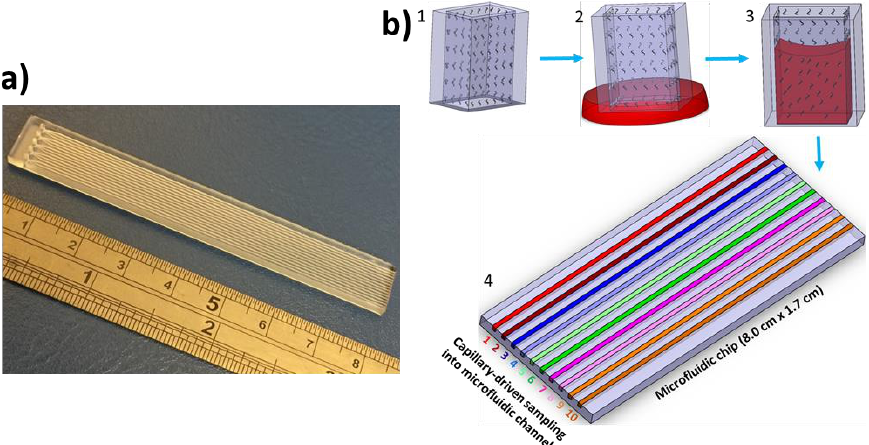
Figure 1. Chip-and-dip device design and working principle. ( a ) Photograph of the chip-and-dip device. ( b ) Schematic of the working principle of the chip-and-dip platform for point-of-care diagnostics in healthcare.